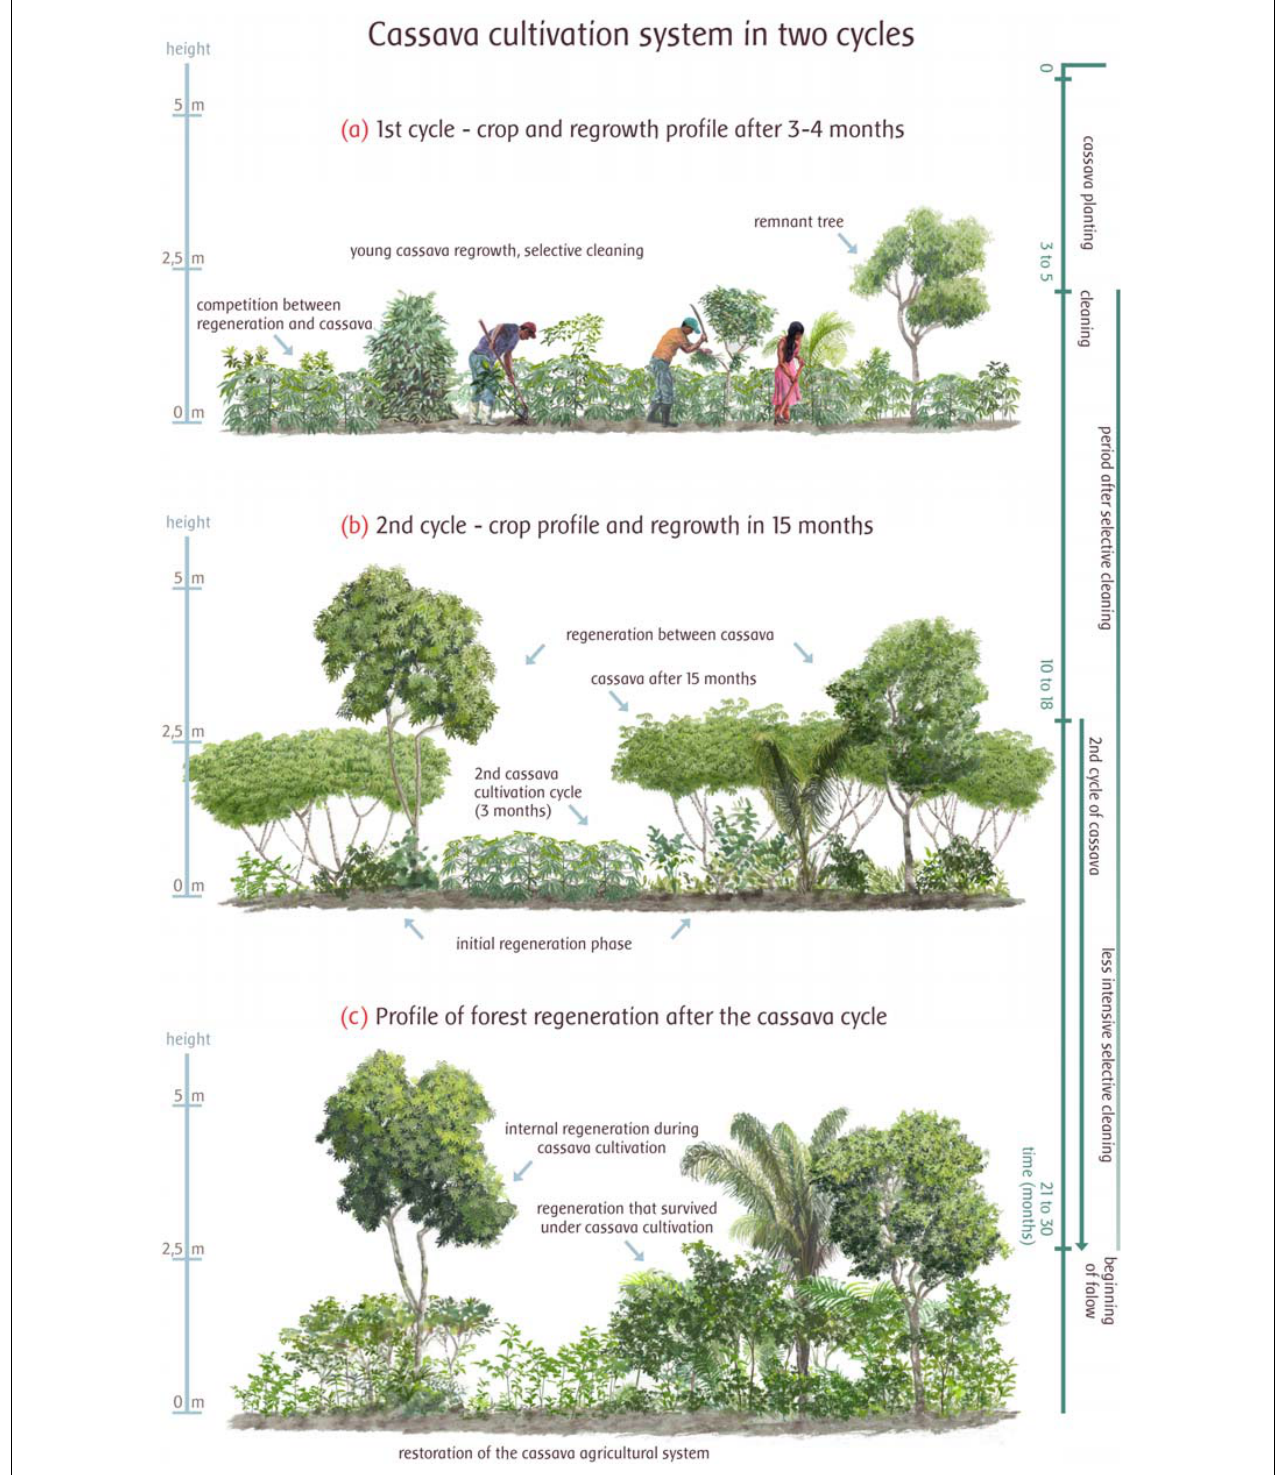
FIGURE 4 | Selective cleaning management ( tukto tawengkeremtowo ) and forest regrowth in the Ikpeng cassava ( Manihot esculenta Crantz) shifting cultivation cycle. (a) When the plot is opened, certain tree species are tolerated and left in the plot. As the crop grows, selective cleaning is repeated after 3–5 months (b) . After the first harvest, cassava is planted again and left to grow among the young regenerating trees (2–5 m) that may be pruned to avoid competition (10–18 months). A less intensive selective cleaning is performed. (c) At the end of the cultivation phase (21–30 months) the protected trees help other regenerating secondary growth species to thrive ( Illustration by Gustavo Marigo — adapted according to Bahuchet and Betsch, 2012).